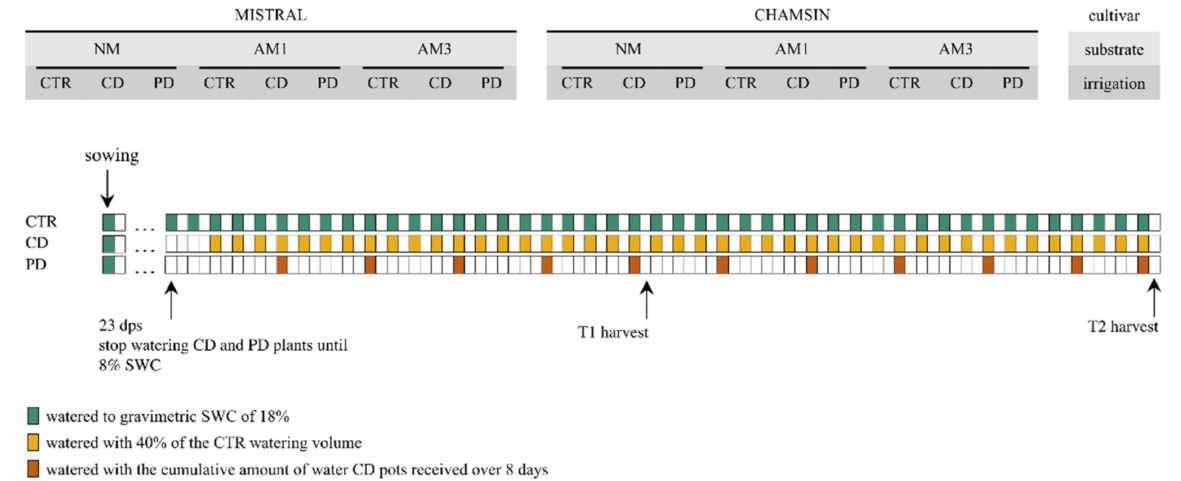
Figure 8. Experimental set-up. Plants of two wheat cultivars ( Triticum aestivum ; Chamsin, Mistral) were either non-mycorrhized (NM), mycorrhized with a single fungus (AM1; Rhizoglomus irregulare ) or with a mixture of three fungi (AM3; R. irregulare , Funneliformis mosseae , F. caledonium ) (factor: substrate). Plants were sown directly in pots (0 days post sowing, dps) and well watered every other day (days represented by boxes, watering events represented by colored fills) until 23 dps, when they were assigned to different irrigation regimes [well-watered (CTR); continuous drought (CD); pulsed drought (PD)] (factor: irrigation); SWC = soil water